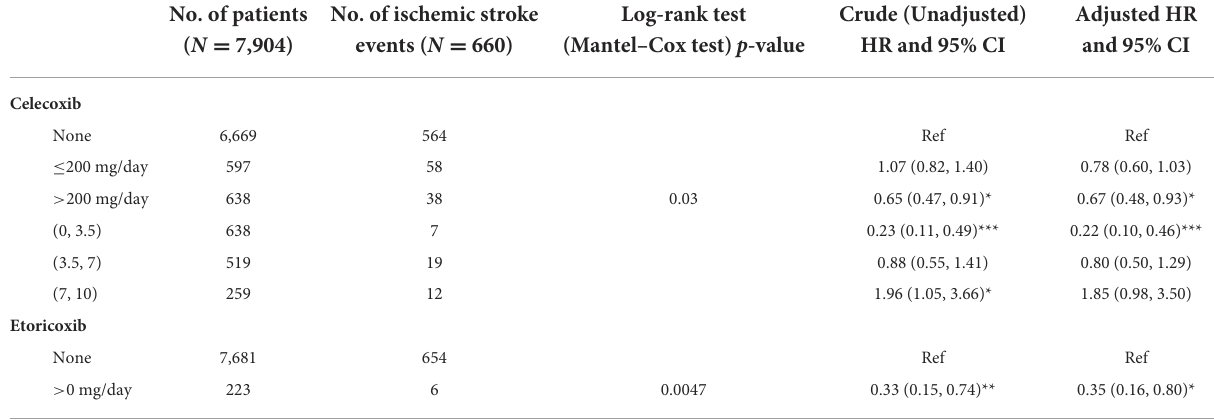
TABLE 2 Cox proportional hazard model for risk of ischemic stroke among patients with rheumatoid arthritis according to the effect of a single drug. No. of